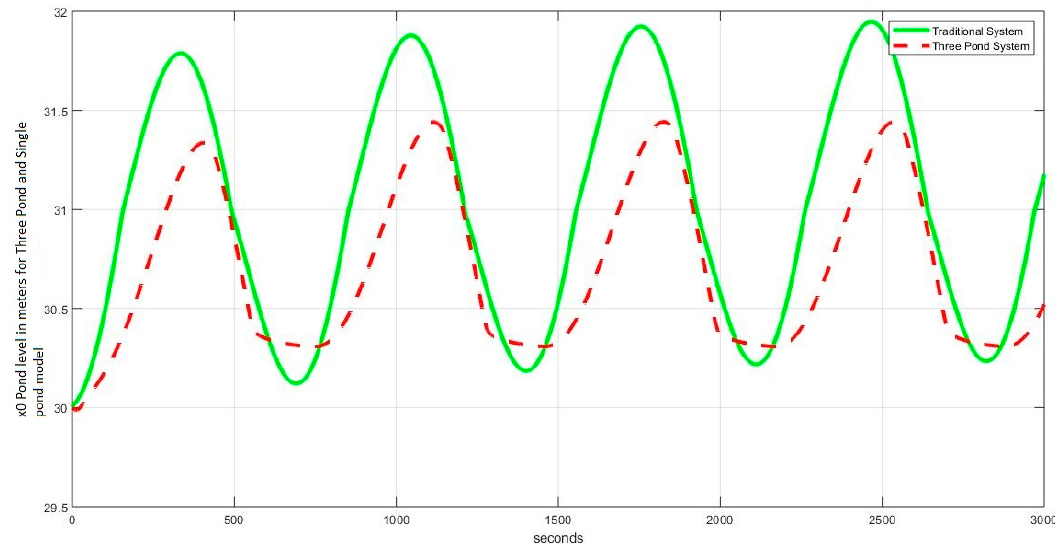
Figure 18. Proposed system (half capacity) vs. traditional system (sinusoidal disturbance, steady state).